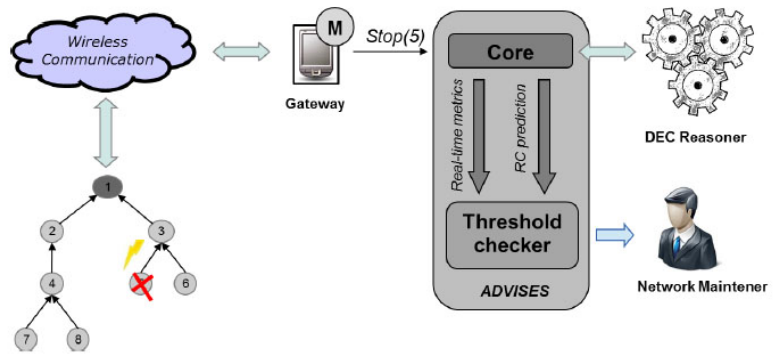
Figure 7. Outcome of ADVISES in runtime mode running. Only timepoint parameter is editable: this is the observation time in an experiment at